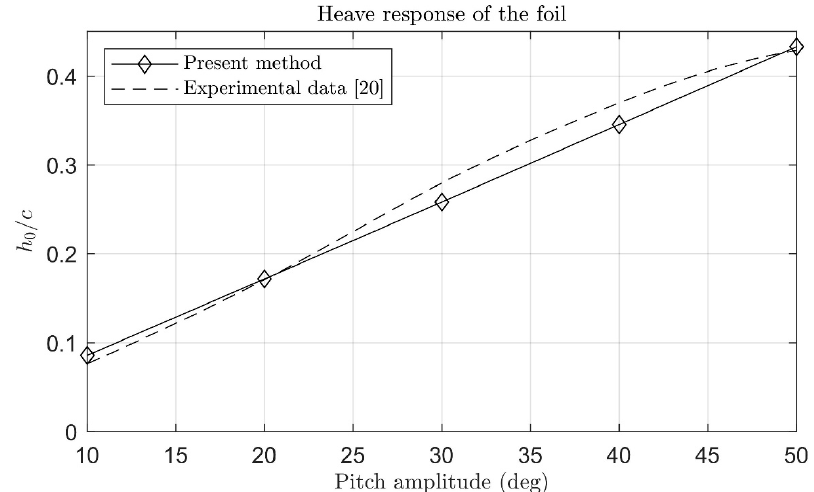
Figure 4. Heave amplitude comparison between the present method and the experiments conducted by Huxham et al. [20] for reduced frequency f ∗ =